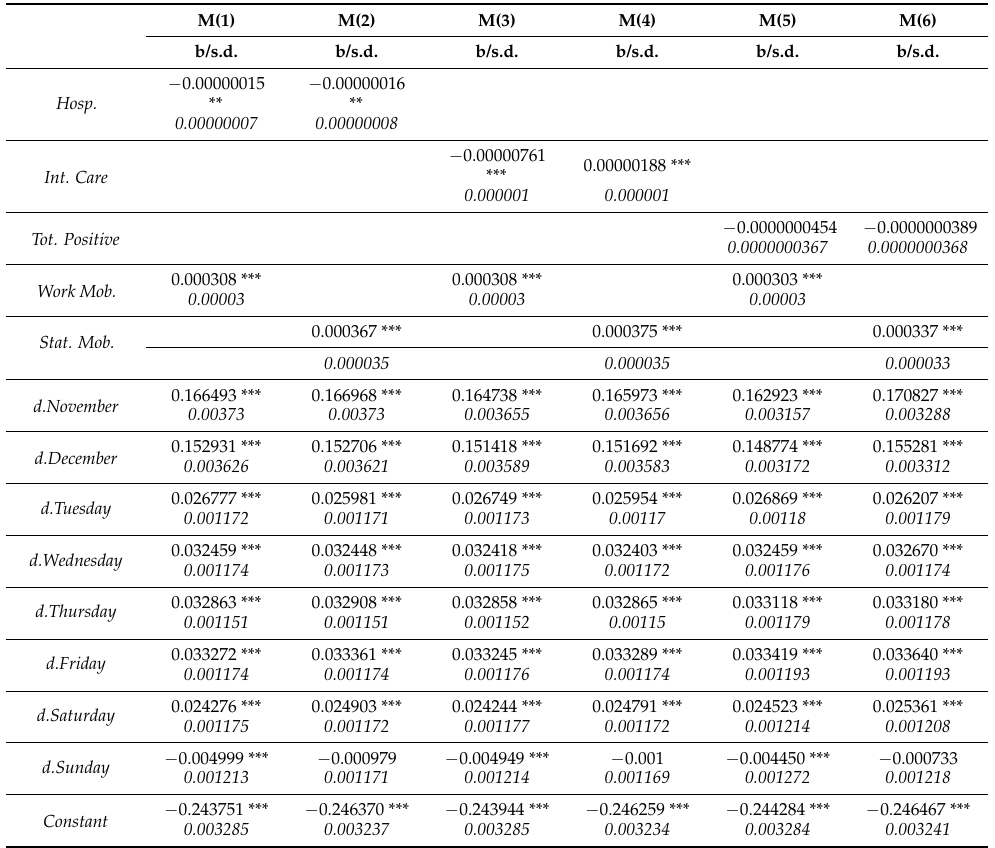
Table 13. Regression Results: Period between 1 October–31